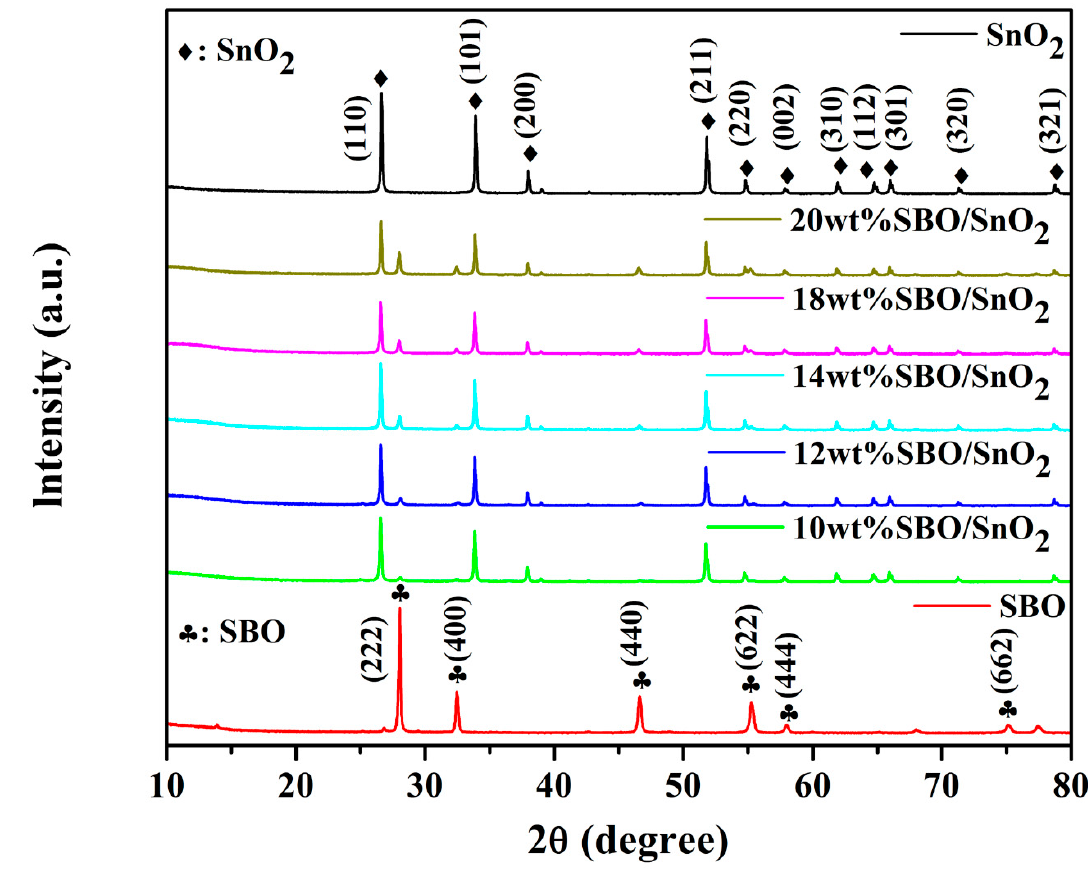
Figure 1. XRD patterns of SnO 2 , SBO, and SBO / SnO 2 composites containing 5 wt%, 10 wt%, 14 wt%, 18 wt%, and 20 wt% of SBO, respectively.